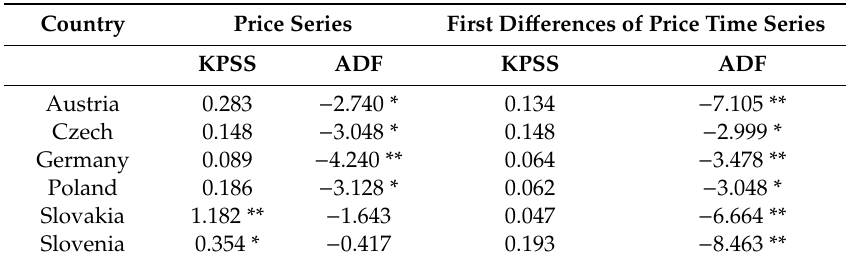
Table 4. KPSS stationarity and ADF non-stationarity tests for beech roundwood prices and the first di ff erences of price time series.